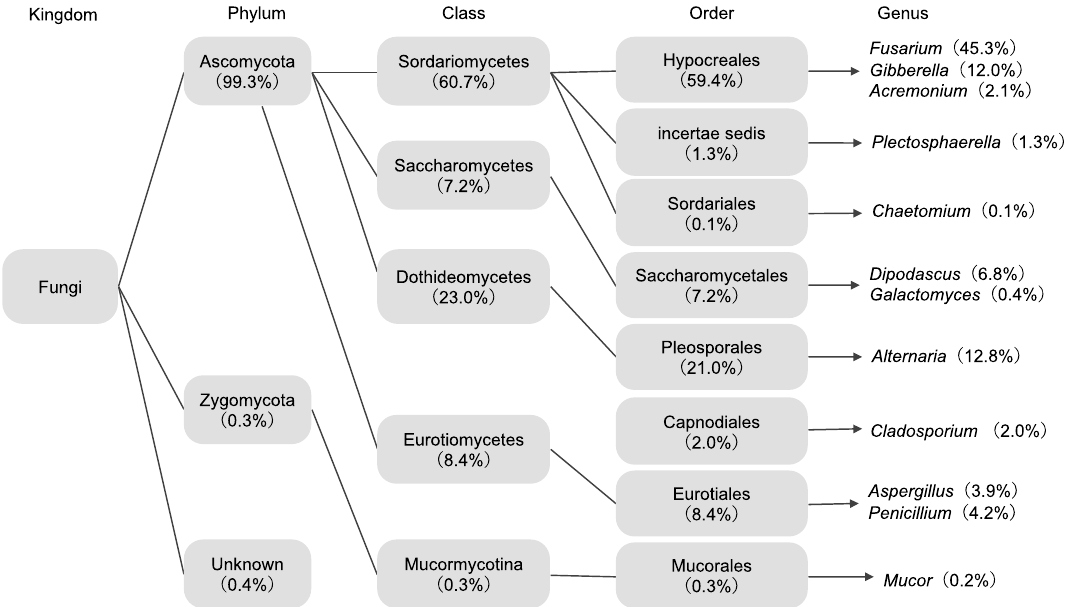
Figure 3. Schematic representation of phylogenetic placement of fungal taxa identified from ITS sequences of endophytes isolated from nature farming tomato plants in three experimental sites in INFRC. The classification follows Hibbett et al. [52] .